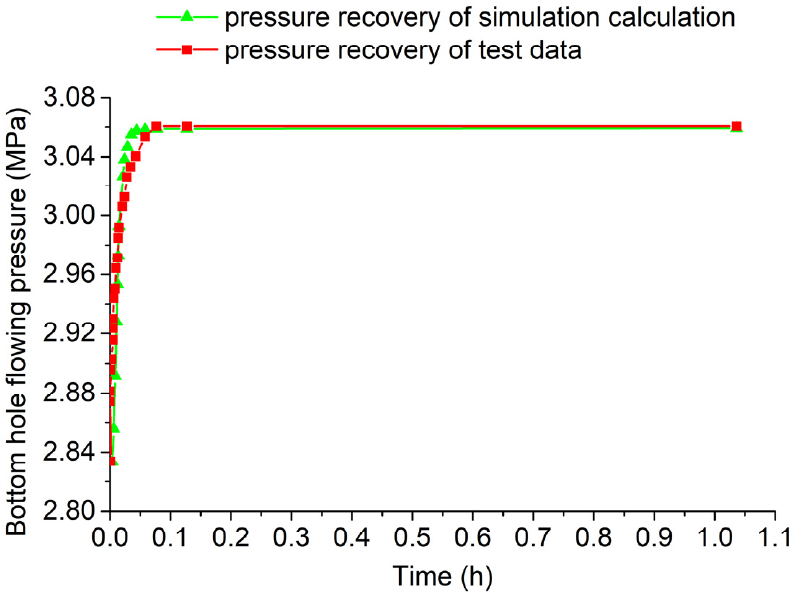
Figure 7. Comparison of pressure recovery simulation calculation results and test data.